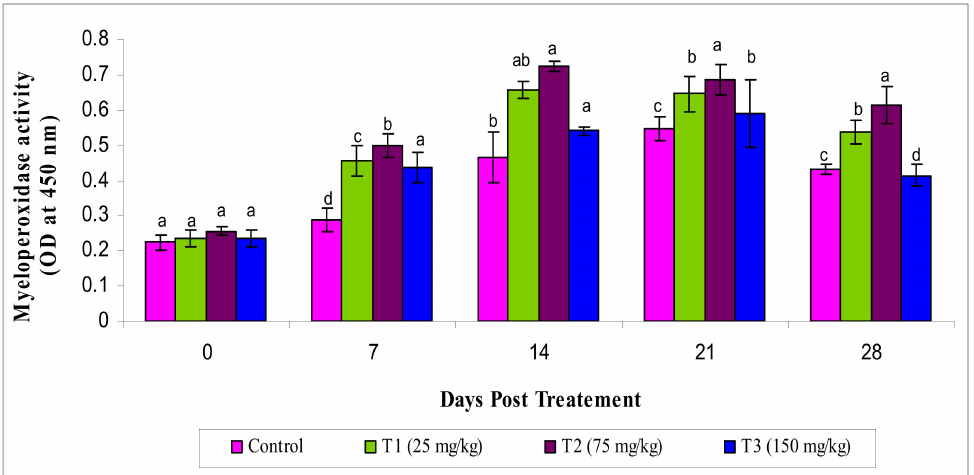
Figure 3. Serum myeloperoxidase activity under di ff erent treatments administered with various levels of methanol extract of Chaetomorpha antennina in Labeo rohita during post treatment days (values are mean ± SE). a,b,c,d Mean values with di ff erent superscripts considered as statistically di ff erent ( p < 0.05); n = 6 for each treatment